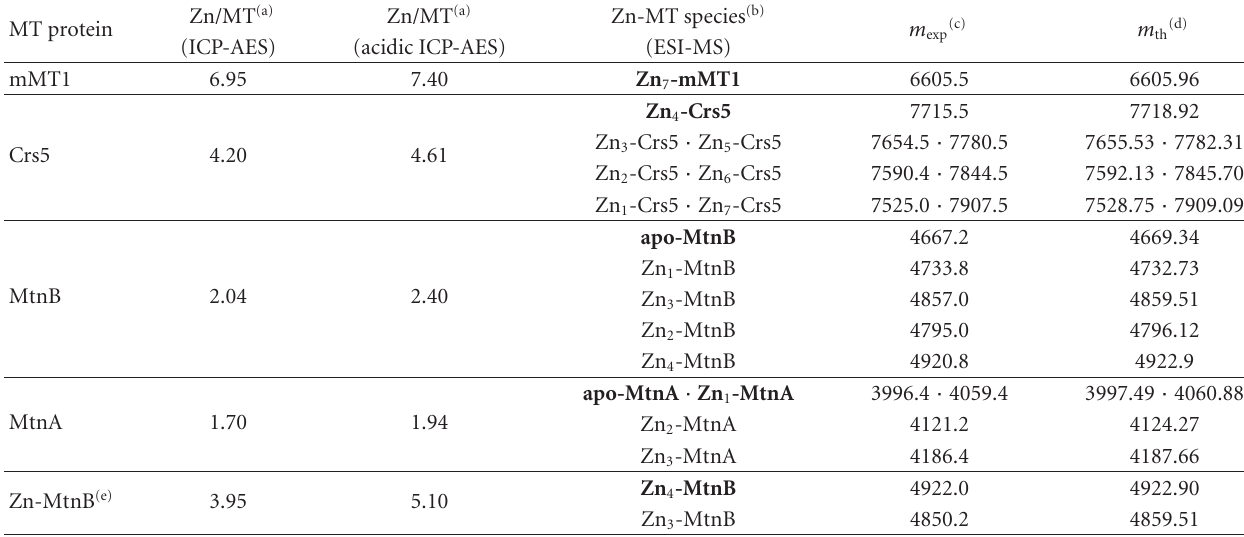
Table 2: Metal-to-protein ratios and molecular masses of the recombinant Zn(II)-MT, complexes obtained from the pGEX expression system with no metal supplementation to the culture, except in the Zn-MtnB used as a control (see Section 2). All the measurements have been performed at least twice, from independently obtained samples.